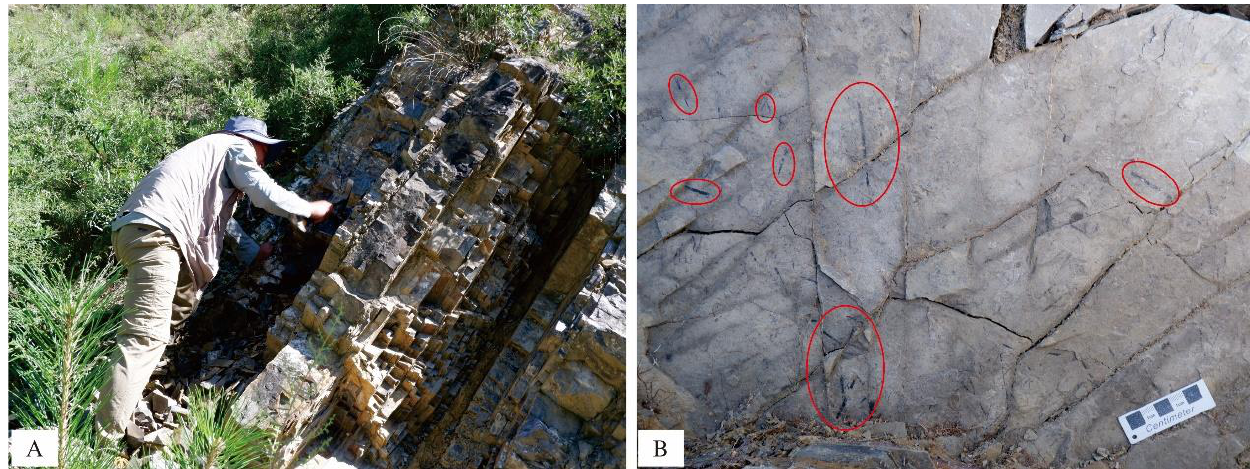
Figure 9. ( A ) Lithological association of the Pingliang Formation in the Guanzhuang section; ( B ) graptolite shale of the Pingliang Formation in the Guanzhuang section (In the red circles are grap- tolites.).